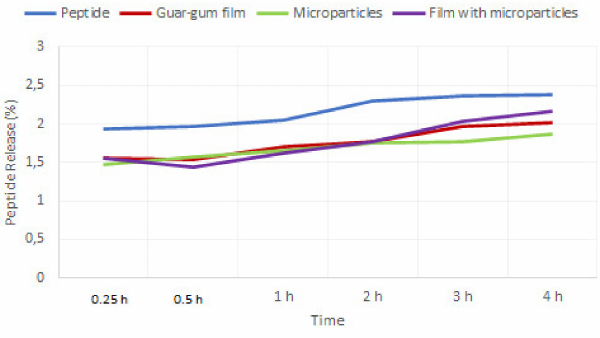
Figure 2. Release profiles of relaxing peptide in different conditions (free relaxing peptide, guar-gum film with peptide, chitosan microparticles with peptide, peptide-loaded chitosan microparticles in guar-gum film) in human physiological